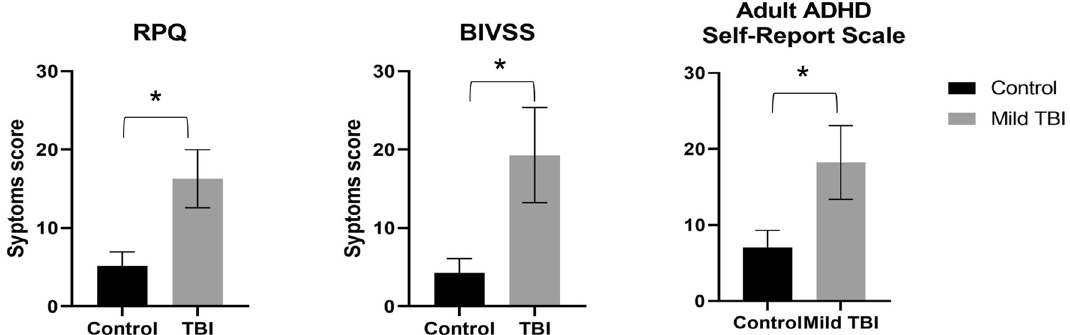
Figure 2. Mean symptoms scores for Rivermead post-concussion symptoms questionnaire (RPQ), brain injury vision symptom survey (BIVSS) questionnaire, and The Adult ADHD Self-report Scale. Error bars represent the standard error of the mean (± SEM). *p <